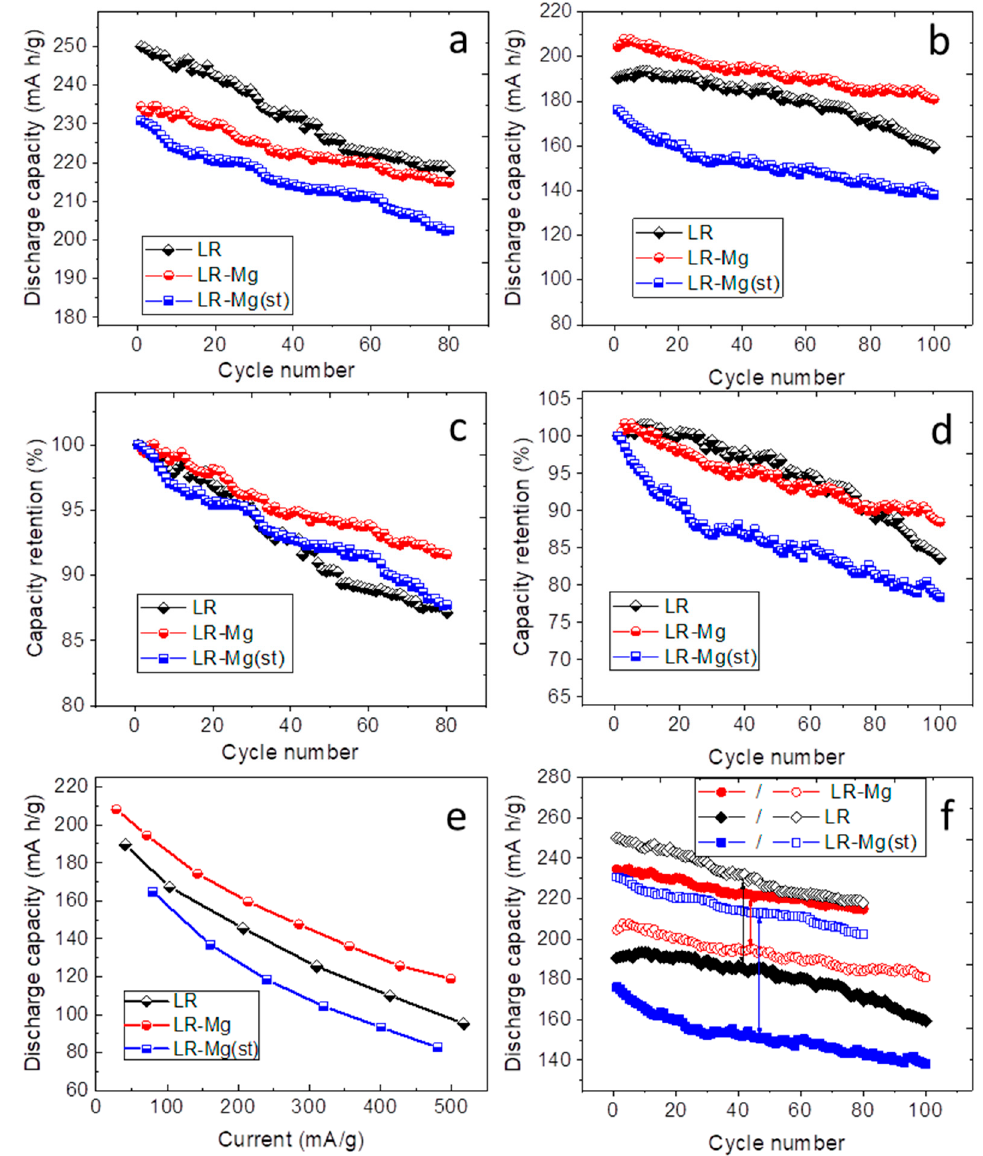
Figure 6. Electrochemical performance of LR, LR-Mg, and LR-Mg(st): discharge capacity as a function of cycle number at the current densities of ( a ) 20 and ( b ) 100 mA/g; capacity retention vs. cycle number at ( c ) 20 and ( d ) 100 mA/g; ( e ) rate performance; and ( f ) comparison of sample cycling performance at different current densities (solid and open symbols correspond to the current densities of 20 and 100 mA/g, respectively).